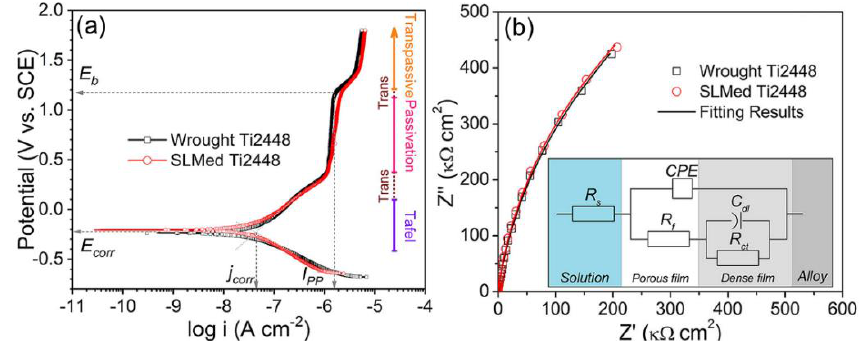
Figure 6. Electrochemical measurements of selective laser melted and wrought Ti–24Nb–4Zr–8Sn: ( a ) Potentiodynamic polarization curves and ( b ) Nyquist plots (the inset is the equivalent circuit diagram). Ti2448 indicated Ti–24Nb–4Zr–8Sn. (Reproduced with permission from [157]. Copyright (2019), ACS Publications). Table 4. Corrosion potentials, corrosion current densities, and high-potential passive current